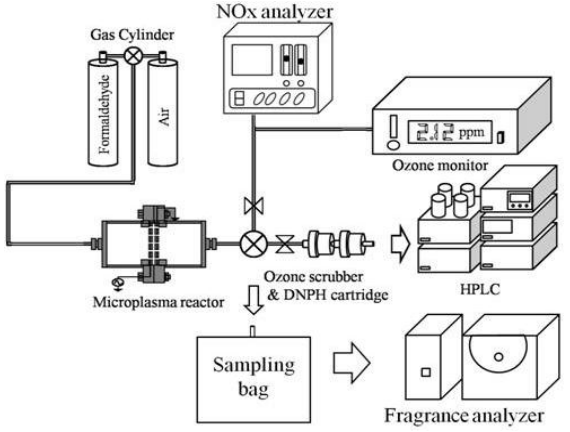
Figure 4. An experimental setup for one pass treatment.